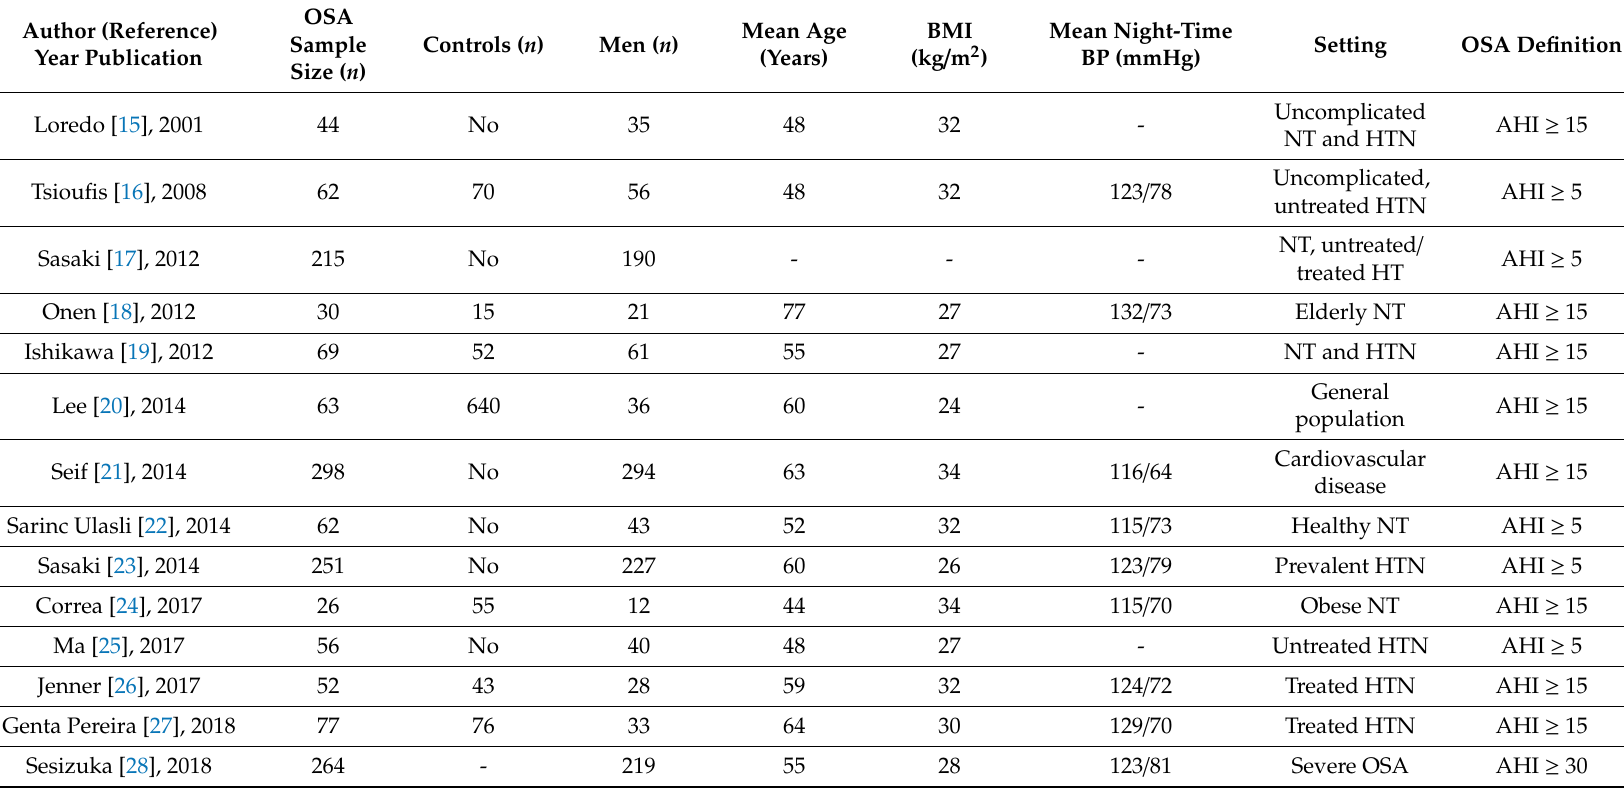
Table 1. Summary of the studies addressing the relationship between obstructive sleep apnea (OSA) and the non-dipping pattern